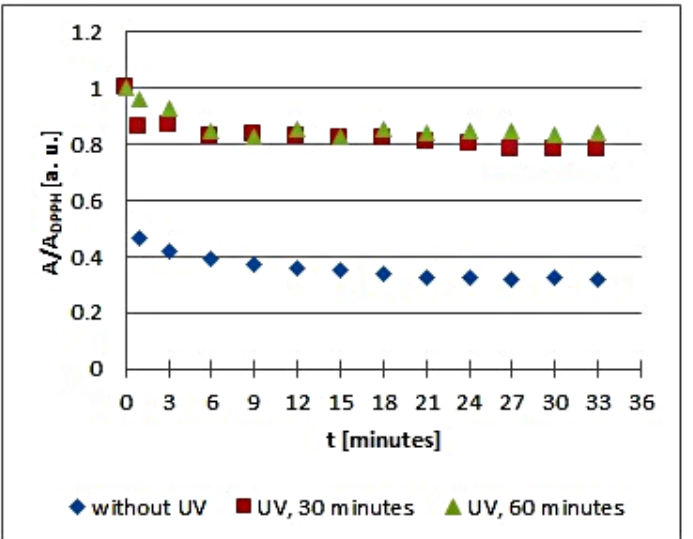
Figure 9. Changes of the relative amplitude (A/A DPPH ) of EPR spectra of DPPH free radicals with increasing time of interactions ( t ) with infusions of Eupatorium cannabinum L. herb. A—amplitude of the EPR line of DPPH free radicals in contact with the tested samples. A DPPH —amplitude of the EPR line of DPPH free radicals in the reference solution. For the reference solution, the relative amplitude (A/A DPPH ) takes a value of 1. Data for the infusions obtained from the plant materials exposed to UVA radiation for 30 and 60 min are presented. For comparison, data for the infusions of the plant material that was not exposed to UVA radiation are also given.